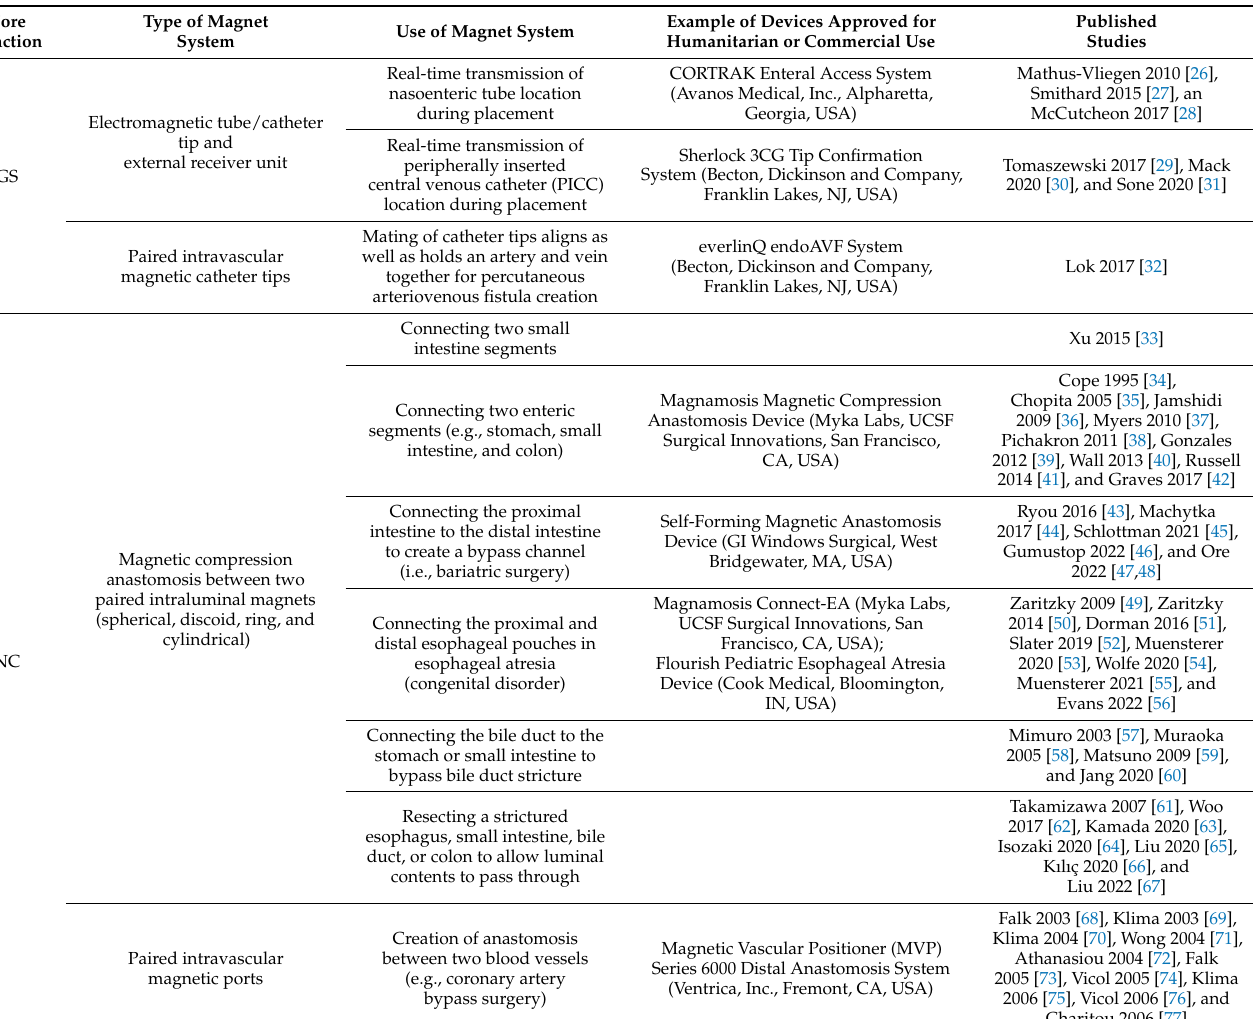
Table 3. Published surgical applications of magnetic